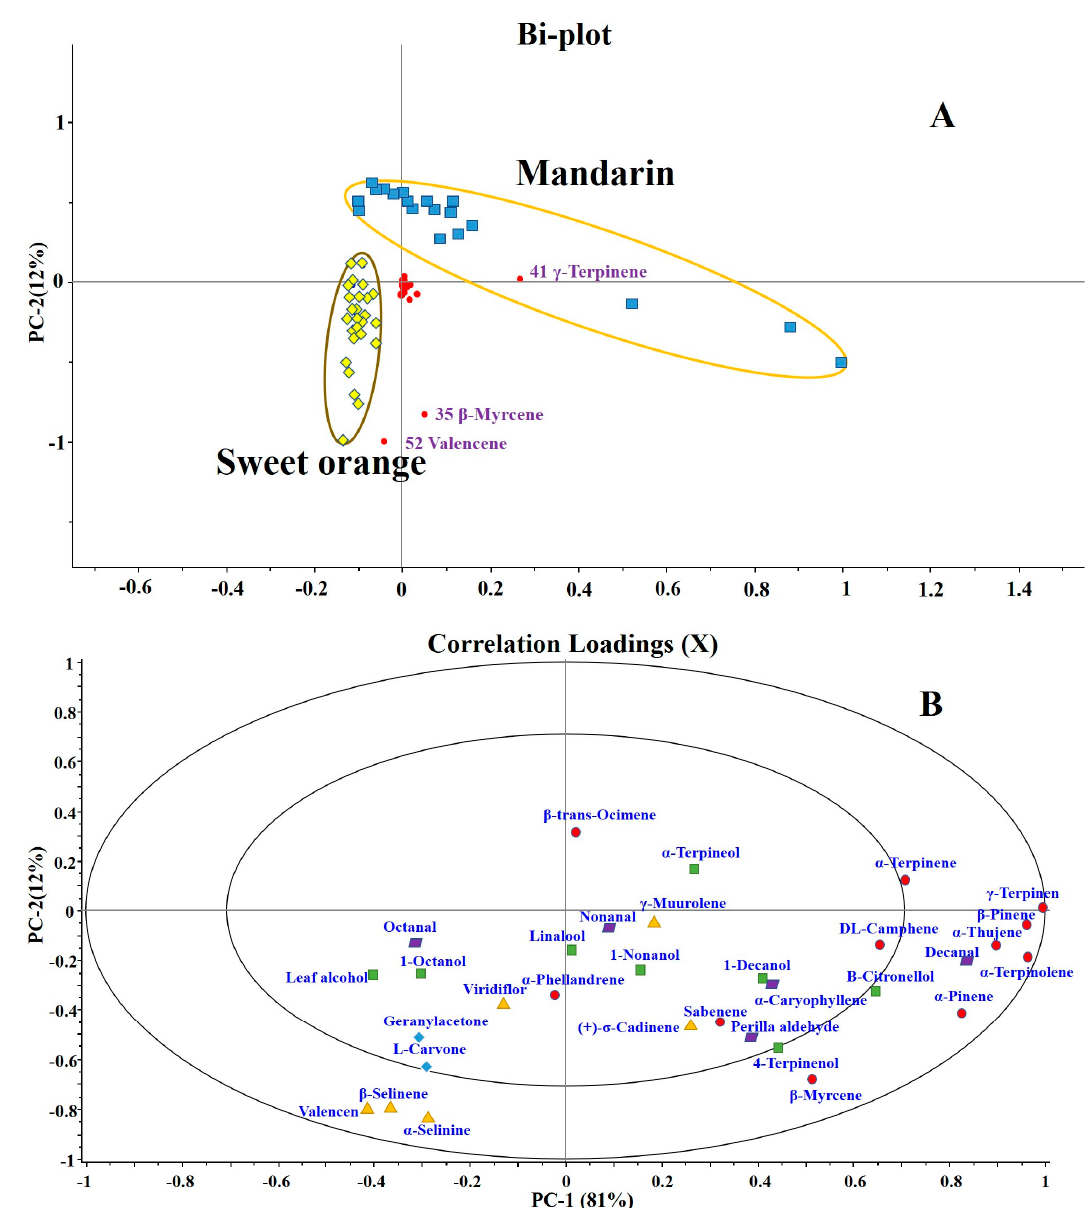
Figure 2. Principal component analysis of sweet orange juices and mandarin juices. ( A ) Scores and loadings biplot. Sweet orange juice and mandarin juice sample scatters are marked with different shapes and grouped; the red dots represent variables whose position distribution indicates their contribution to the sample scores. ( B ) Correlation loadings of each variable. Each type of substance is shown in different shapes and colors.